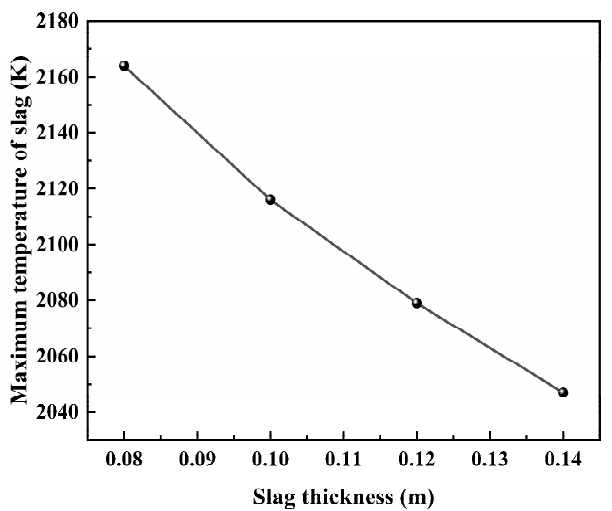
Figure 6. Effect of slag thickness on maximum slag temperature.